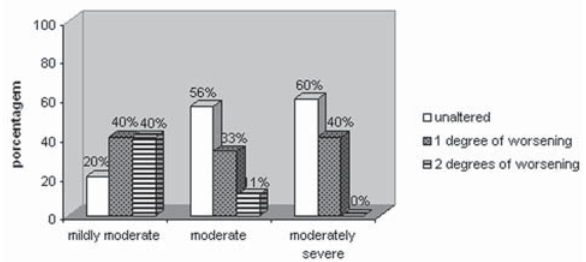
FIGURE 5- Patient distribution that presented evident hypernasality as to resonance modificaton after surgery